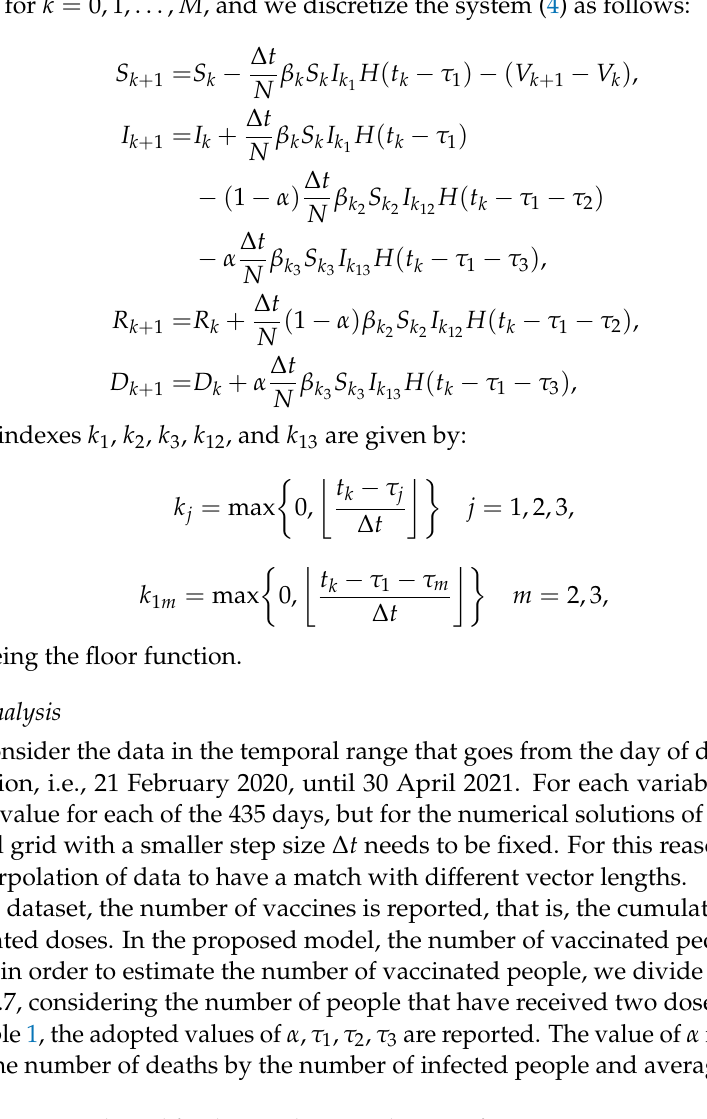
Table 1. Parameters adopted for the simulation in the case of